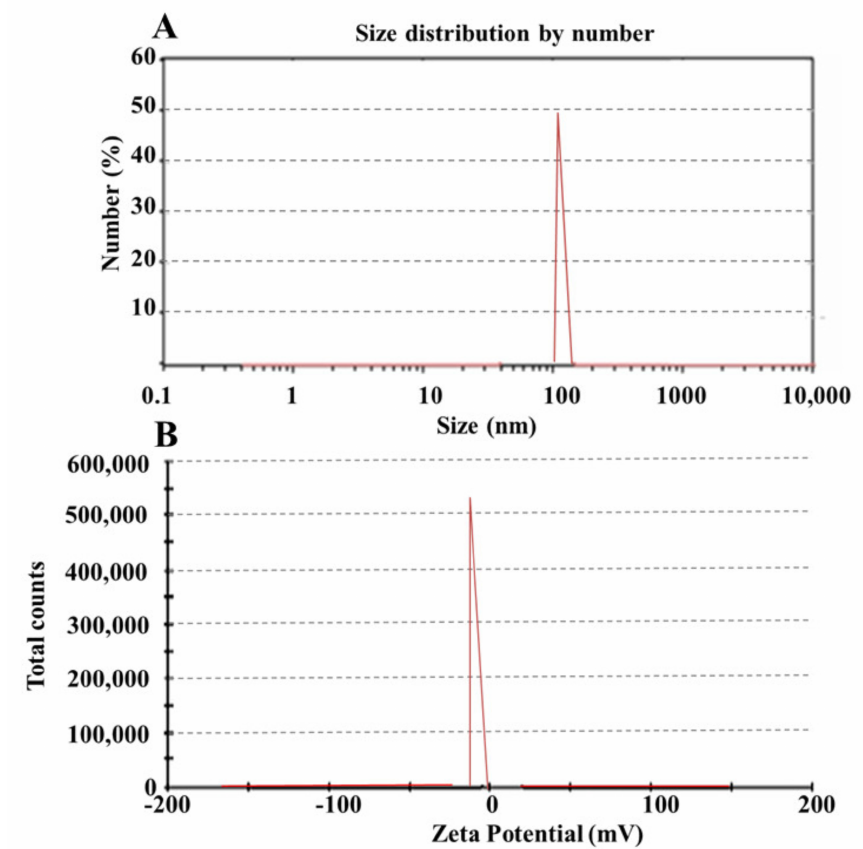
Figure 2. Zeta sizer ( A ) and zeta potential ( B ) of the SPC3